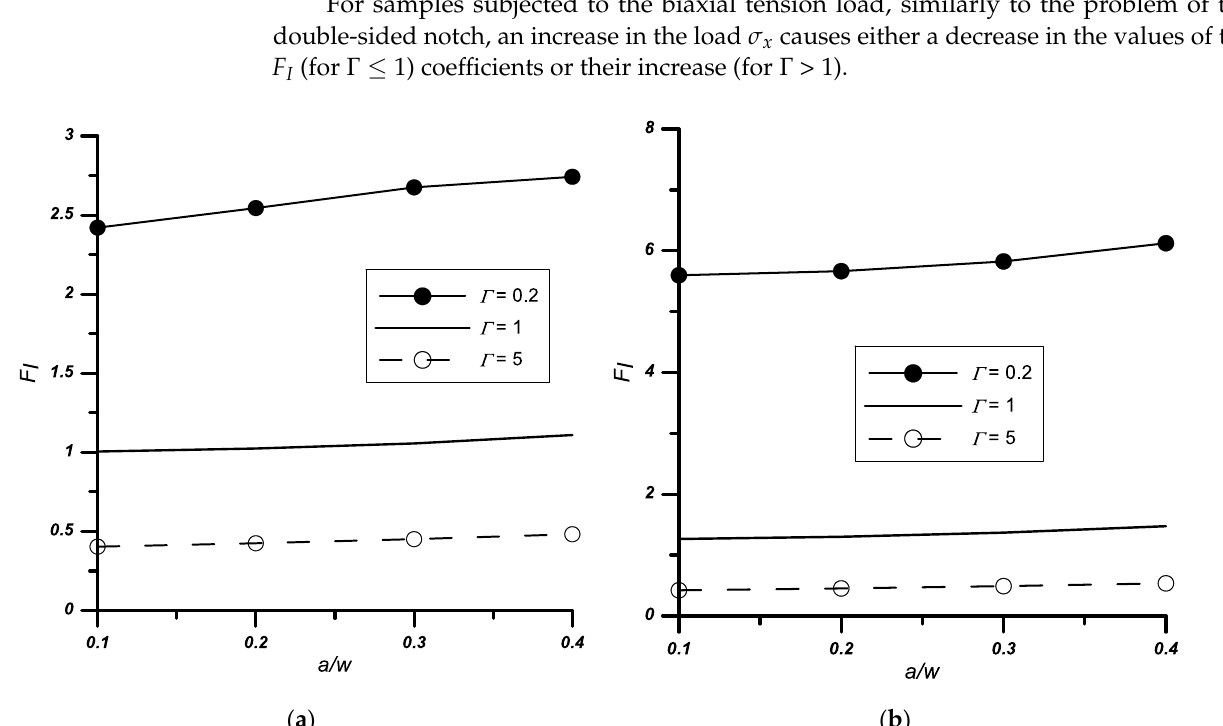
( b ) Figure 10. Variation of the normalised stress intensity factors F I with the relative stiffness Г and the notch angle 2 ψ , ( a ) for σ x / σ y 1 = 1, ( b ) for σ x / σ y 1 = 0.5, a/w = 0.4. For samples subjected to the biaxial tension load, similarly to the problem of the double-sided notch, an increase in the load σ x causes either a decrease in the values of the F I (for Г ≤ 1) coefficients or their increase (for Г > 1).